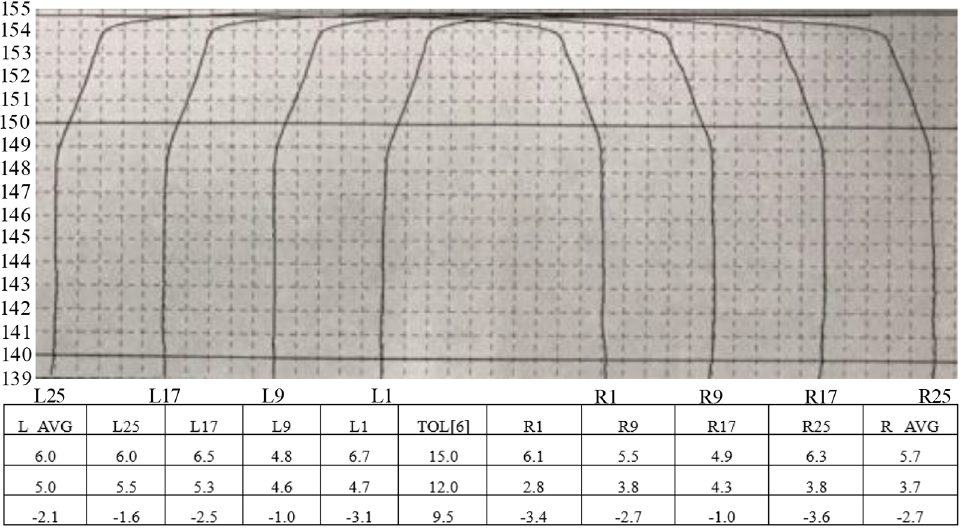
Fig. 6. Pro fi le measurement curve of